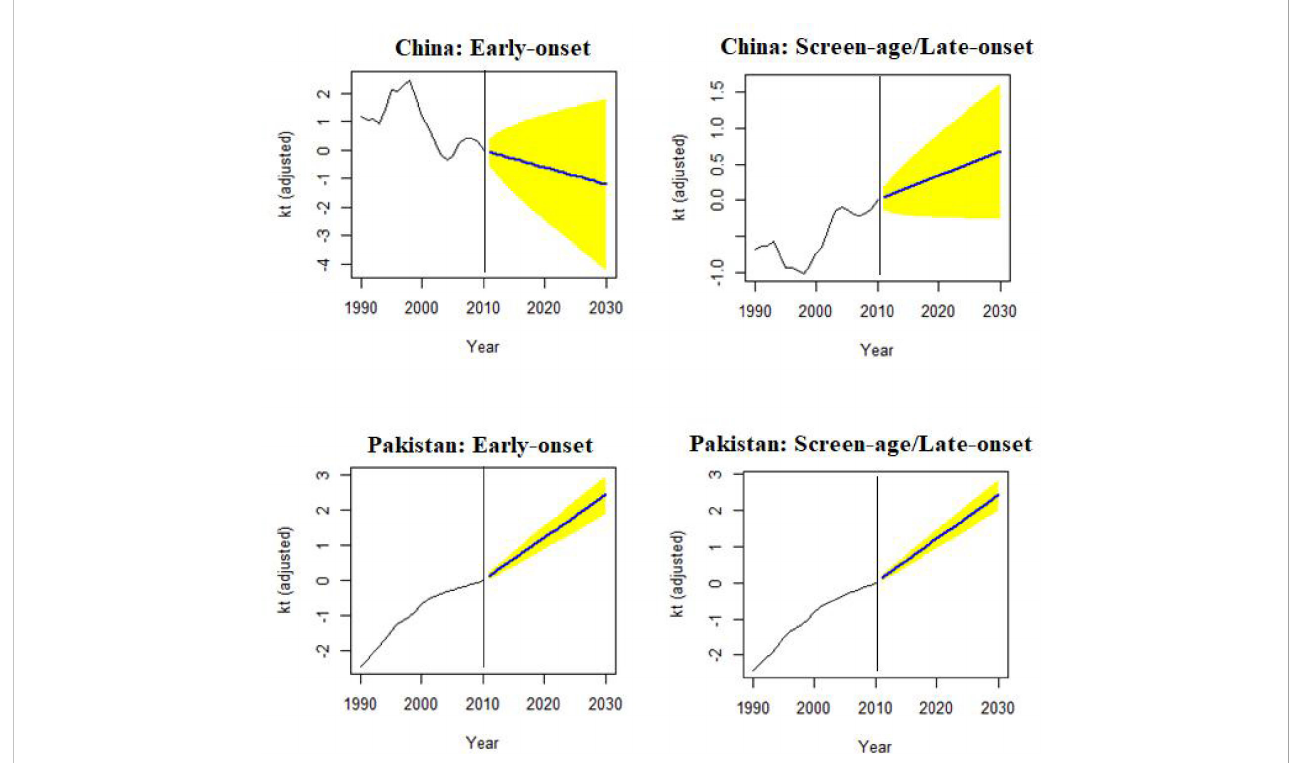
FIGURE 7 Forecast of mortality index ( k t ) to 2030, in the early-onset and screen-age/late-onset female breast cancer population for China and